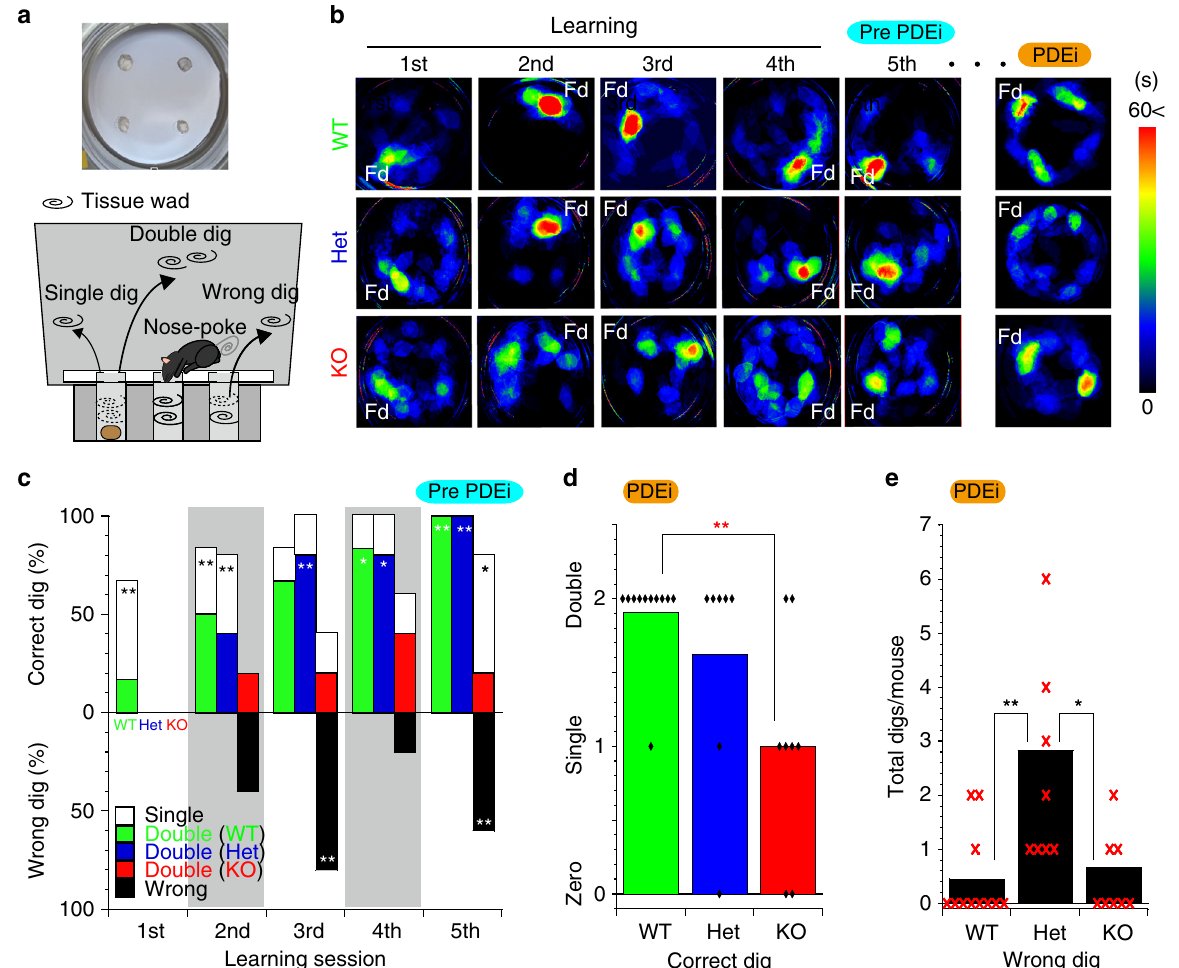
Fig. 9 OMP-de fi cient mice lose olfactory sensitivity during snif fi ng. a Schematic representation of the odour search assay. Platform for the odour-source- locating assay (upper). Testing scheme for the odour-source-locating assay (lower). A starved mouse was tasked with fi nding a piece of food hidden in one of the four holes by successively removing two tissue wads. b Heatmaps of the time spent by animals during each session. Fd food reward, PDEi session with intranasal PDEi administration. c Success-error histogram during each learning session. n = 6, 5 and 5 animals in the WT, Het and KO groups, respectively. d The numbers of correct digs by mice challenged with PDEi. e The number of wrong digs by mice challenged with PDEi. Diamonds and X- marks indicate the numbers of mice used in ( d , e ); 9, 7 and 7 for WT, Het and KO mice, respectively. * P < 0.05, ** P < 0.01. Statistics: c one-way ANOVA and post hoc Bonferroni test, Double dig, F (3, 15) = 17.88, P = 0.0002 and P WT vs Het > 0.999, P WT vs KO = 0.0004, P Het vs KO = 0.0006. Single dig, F (3, 15) = 1.117, P = 0.3567; P P = 0.6178, P = 0.6741. Wrong dig, F (3, 15) = 6.703, P = 0.00999: P P = WT vs Het > 0.999, WT vs KO Het vs KO WT vs Het > 0.999, WT vs KO 0.0186, P Het vs KO = 0.0243. n = 6, 5 and 5 for WT, Het and KO mice. d Two-sided Kruskal – Wallis test; P = 0.012. Mann – Whitney U test for further comparison; P WT vs Het = 0.36, P WT vs KO = 0.0044, P Het vs KO = 0.097. n = 11, 8 and 8 for WT, Het and KO mice. e Two-sided Kruskal – Wallis test; P